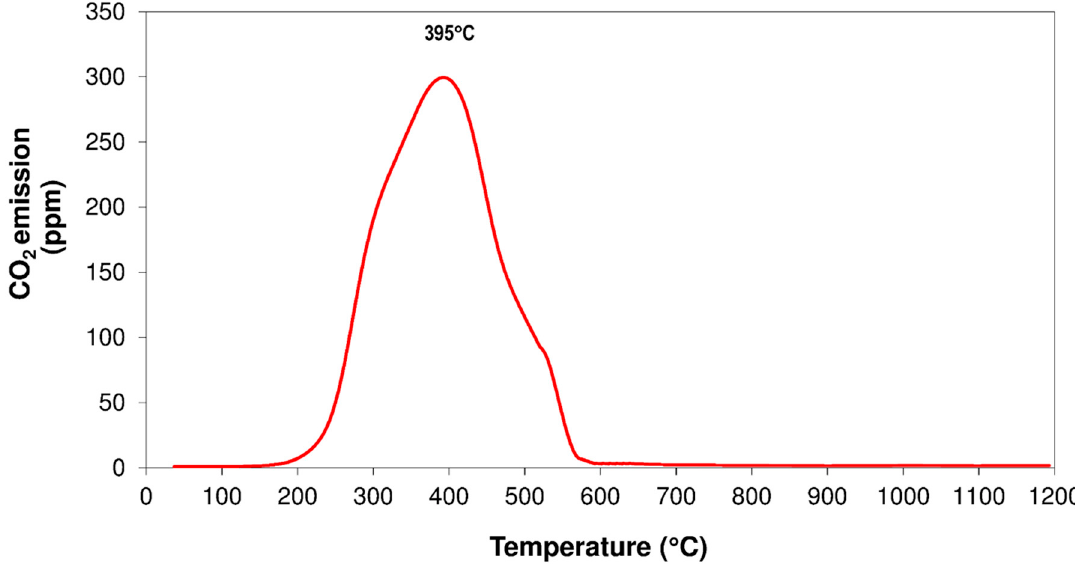
Figure 8. CO 2 curve emission for sample BCS-CRM 348 Ball clay.